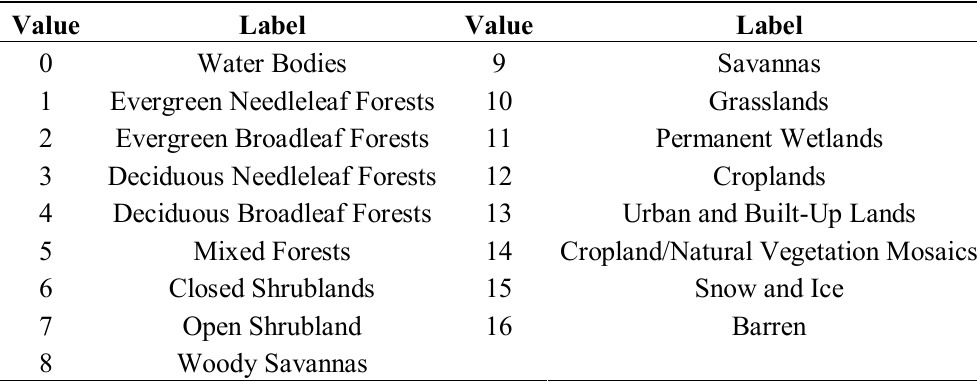
Table 1. The International Geosphere-Biosphere Programme (IGBP) land cover classification